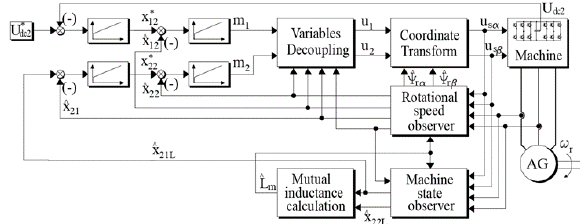
Fig. 3. The scheme of the nonlinear multiscalar control structure of asynchronous generator (AG).